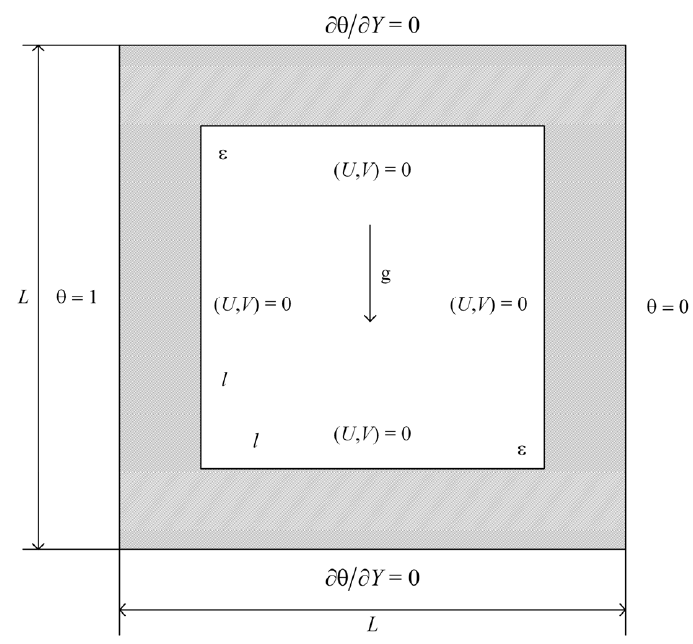
Figure 1. A typical representative cell of the char layer.